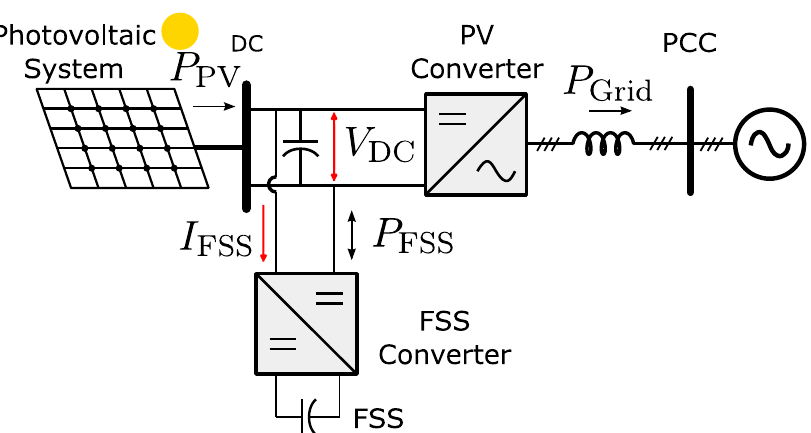
Appl. Sci. 2020 , 10 , x FOR PEER REVIEW Figure 2. Proposed AS and their categorization [18,27,28] . Figure 2. Proposed AS and their categorization [18,27,28].